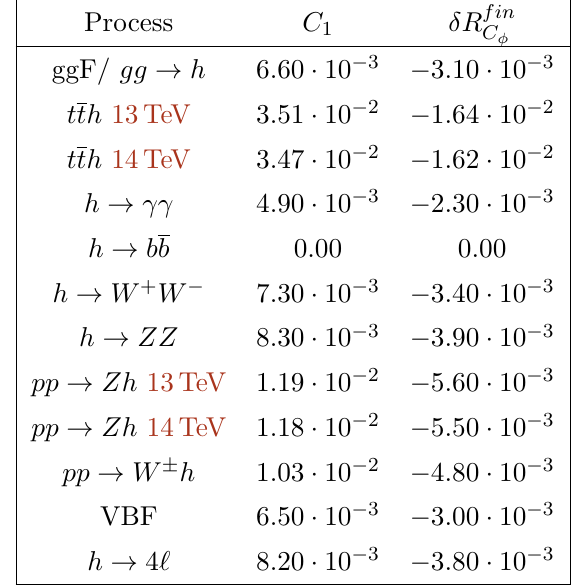
Table 2 . The relative correction dependence on C φ for single-Higgs processes, taken from [24]. The C 1 coefficients are to be used in eq. (4.4), while for a direct comparison with the effect of the four-fermion operators, we quote the translated effect δR fin , which can be used directly in C φ √ eq. (3.22). If the value of s is not indicated the effect is the same for both 13 and 14